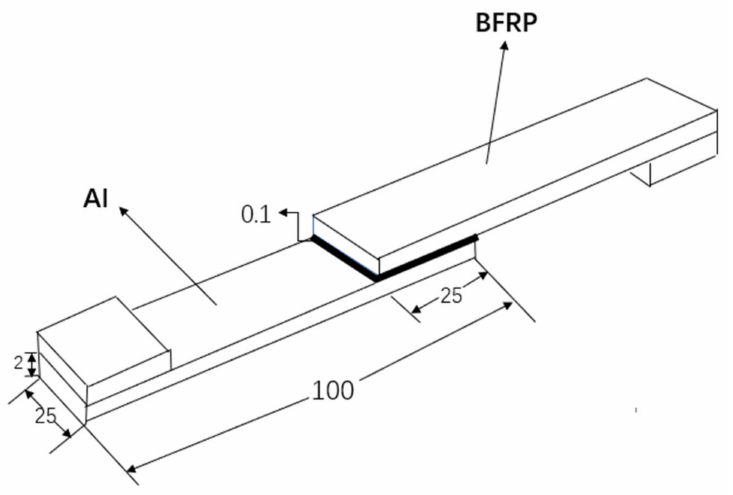
Figure 1. Configurational geometry and dimensions